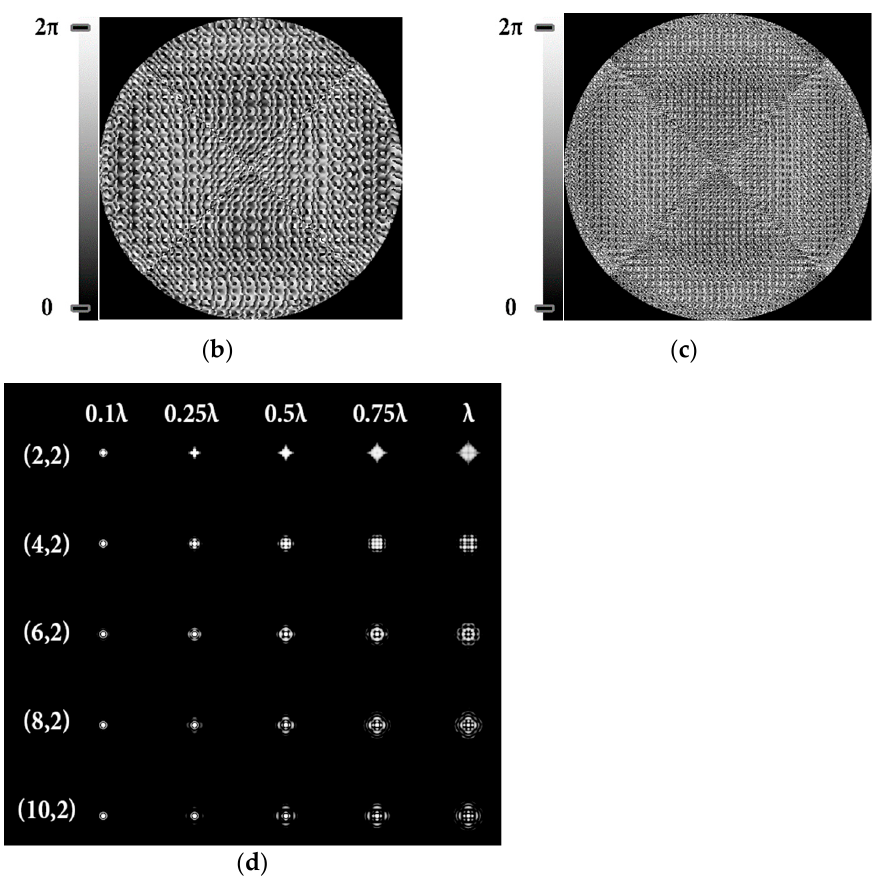
of aberrated PSF to diffraction orders is shown). aberrated PSF to diffraction orders is